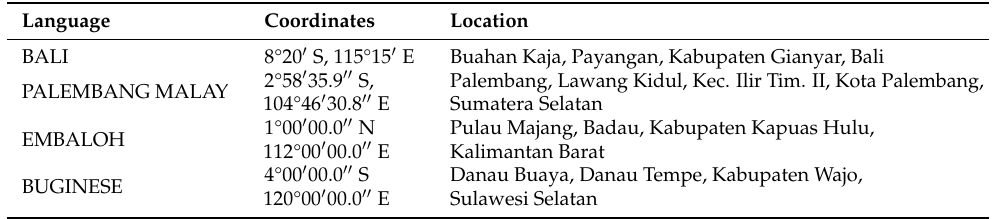
Table 6. Coordinates and language locations from Bali to Buginese obtained using